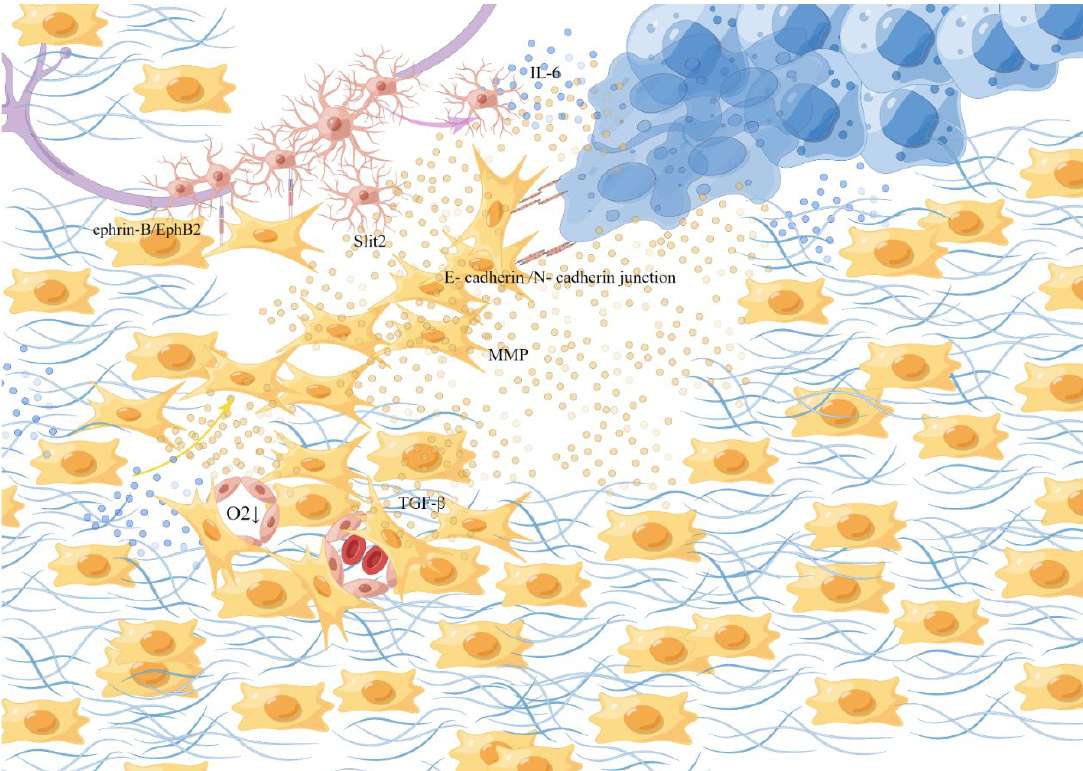
Figure 3. Fibroblasts. Local tissue fibroblasts are activated into CAFs, due to the influence of tumor- derived paracrine factors and cytokines. They help with the synthesis, deposition, and remodeling of most of the ECM in the tumor matrix. CAFs secrete TGF- β to synthesize collagen, stiffen the tissue, destroy the microvascular structure, and collapse the nearby blood vessels to promote hypoxia, form a track contributing to the movement, overflowing, and diffusion and of the cancer cells, and exert physical force by the anisotropic E-cadherin/N-cadherin in junction, degrade extracellular collagen and induce migration of SCs through the ephrin-B/EphB2 signaling pathway. This picture is drawn by Figdraw (www.figdraw.com).